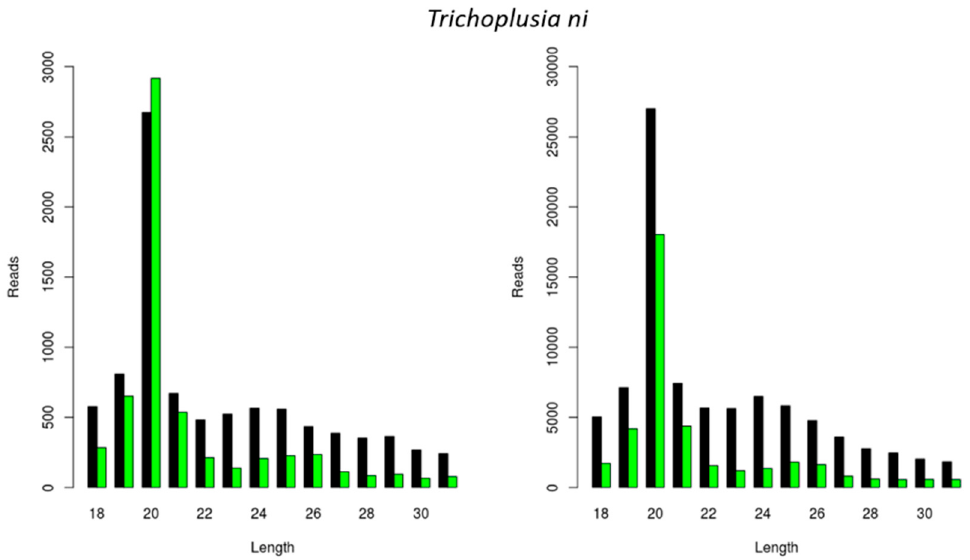
Figure 3. Generation of Macula-like Latent Virus (MLV)-derived siRNAs in two stocks of Trichoplusia ni High Five cells. Length distribution of small RNAs mapping to the MLV in a stock of High Five cells persistently infected with MLV and induced with a CrPV infection ( left ); and in a stock of High Five cells persistently infected with MLV and the FHV ( right ). Reads ( y axis): number of reads. Length ( x axis): length (nt) of the reads. Black: sense reads. Green: antisense reads. To avoid degradation products and general contaminants, reads shorter than 18 nt and longer than 31 nt were not included. Mapping was performed with Bowtie2, and graphs were obtained with the viRome package in R.